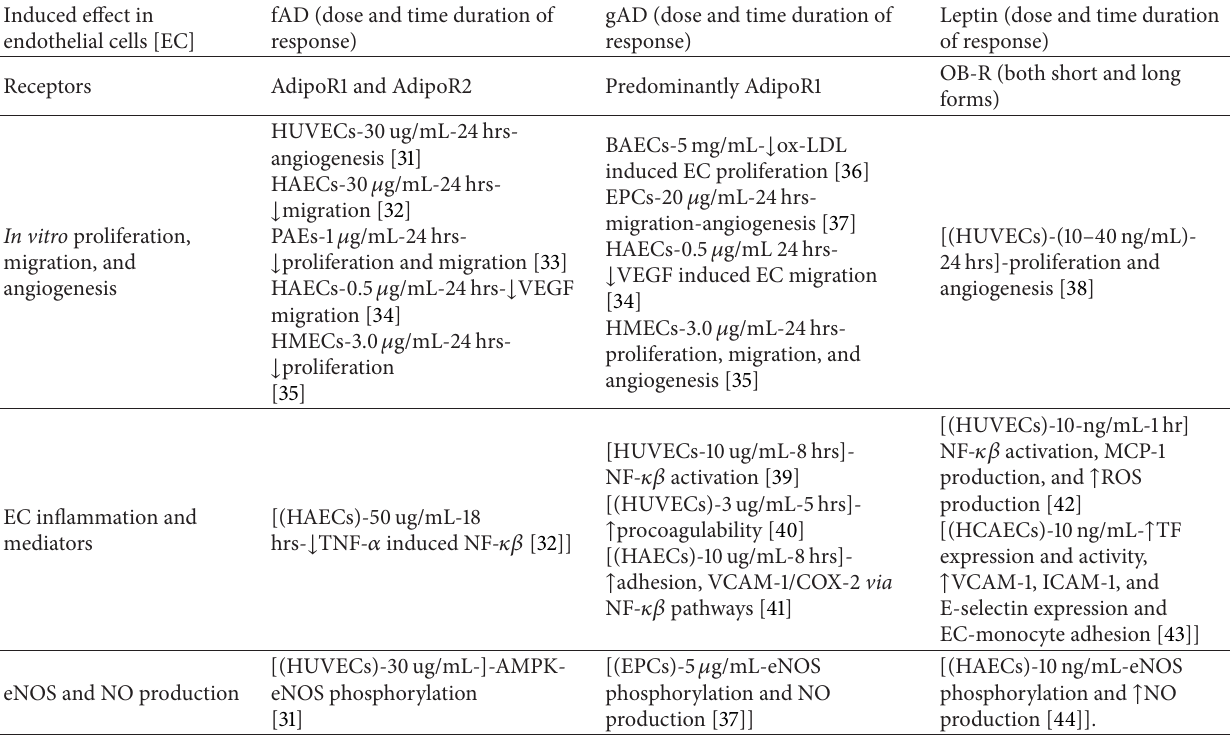
Table 1: Differential effects of fAD, gAD, and leptin in endothelial